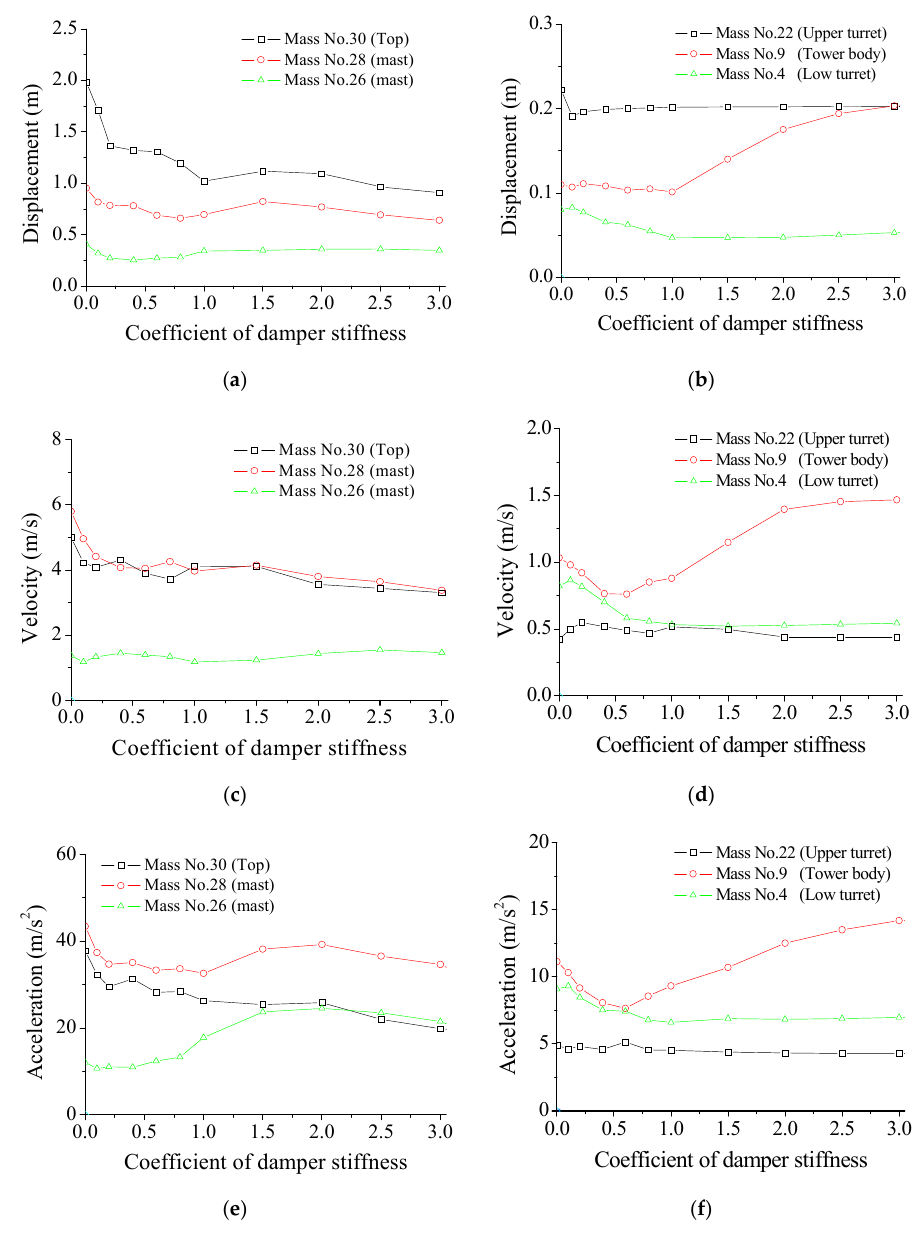
Figure 9. Effects of damper stiffness on peak responses. ( a ) Displacement at mast; ( b ) Displacement at tower; ( c ) Velocity at mast; ( d ) Velocity at tower; ( e ) Acceleration at mast; ( f ) Acceleration at tower.